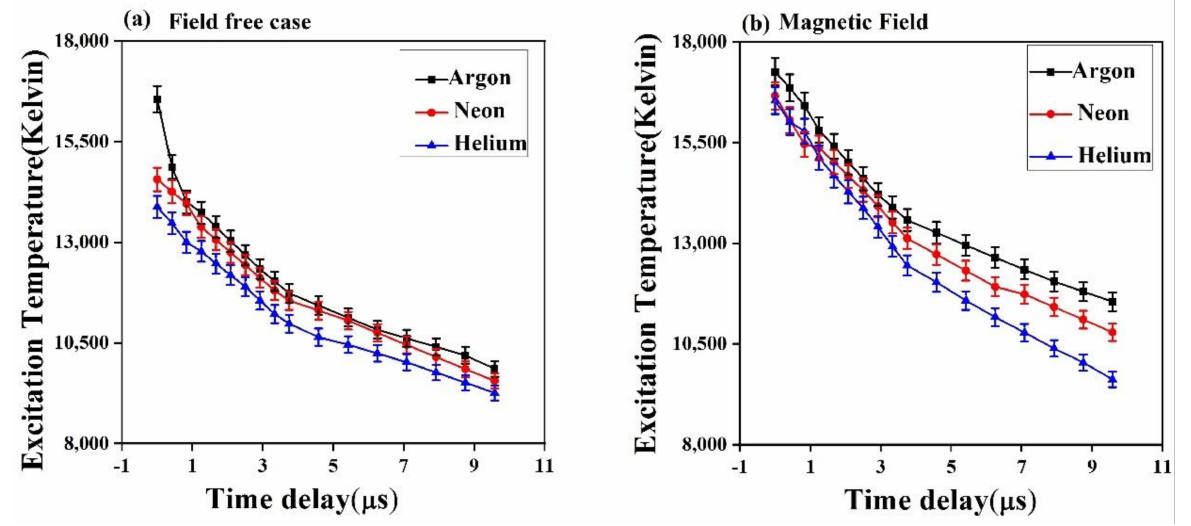
Figure 7. The variation of T exc of LPP of Mg at different time delays in ( a ) the absence and ( b ) the presence of a magnetic field under Ar, Ne, and He.